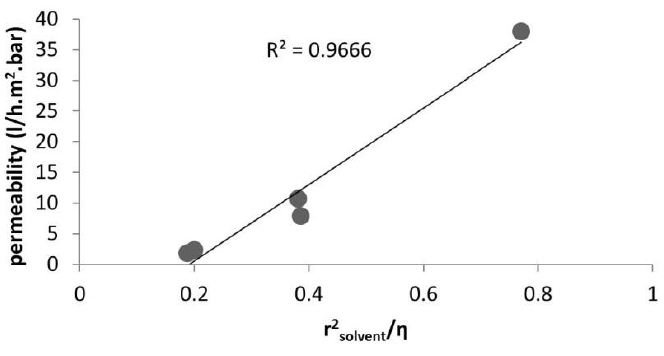
Figure 4. Solvent permeability versus 𝑟 solvent2 /𝜂 studied by [40]. Table 4. Solvent permeability through the ceramic membrane reported by [49]. Pore radius of